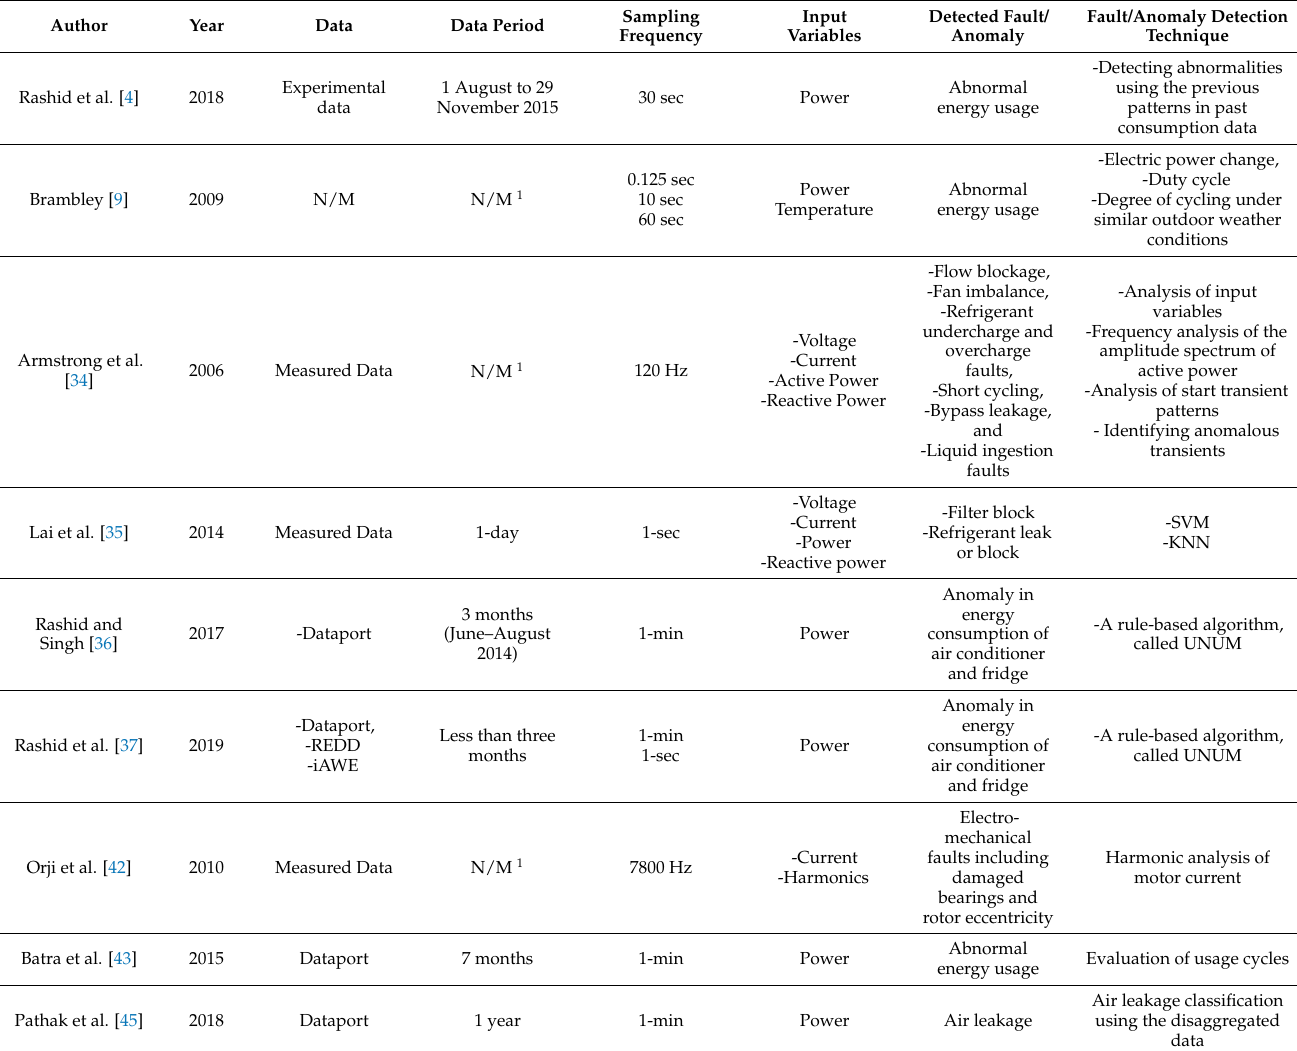
Table 2. Main characteristics of NILM-based FDD techniques for